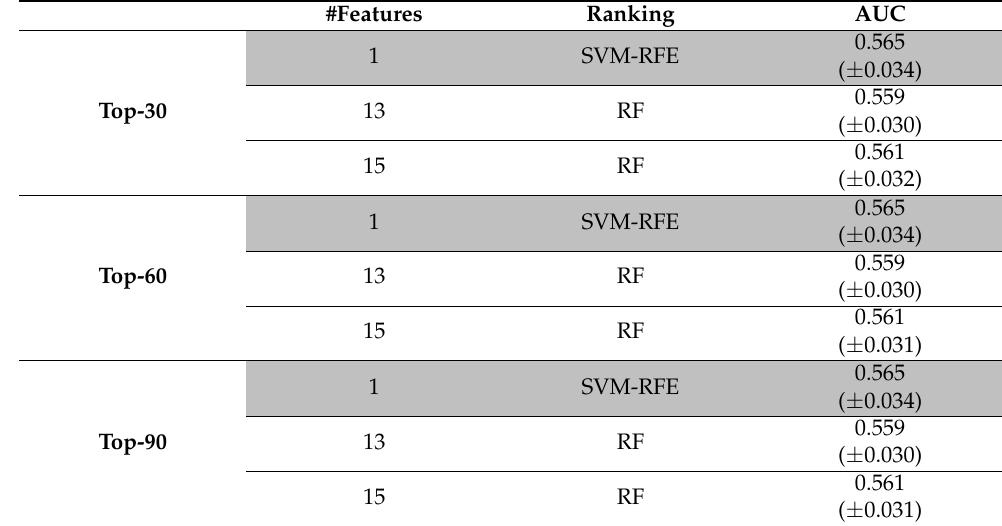
Table 3. Boosted Trees classifier. In gray background the number of features with the best